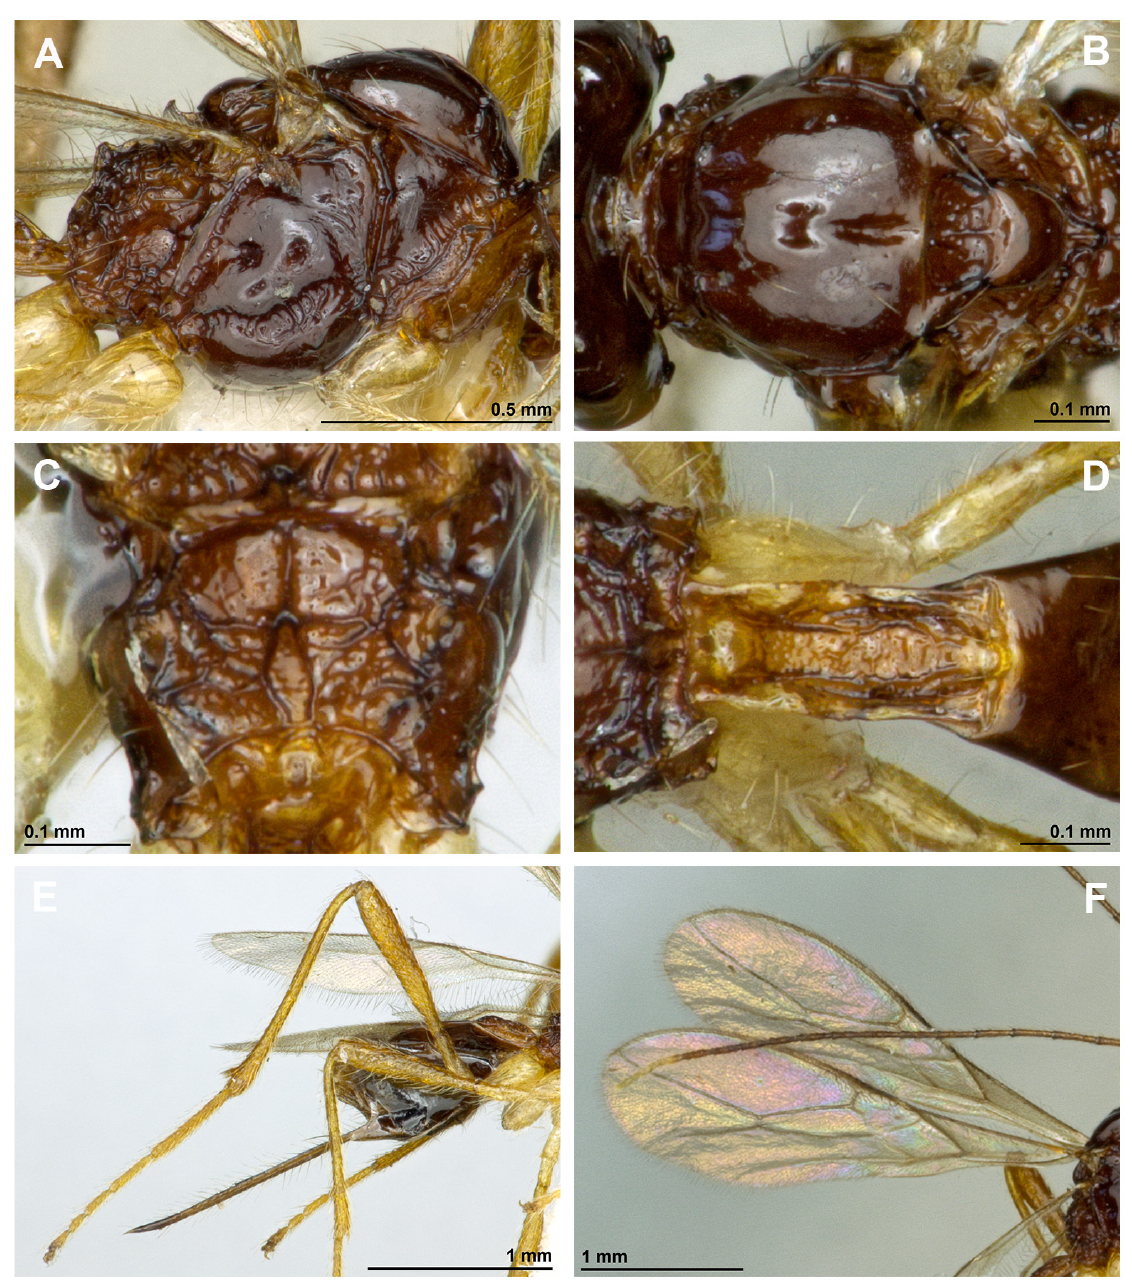
Fig. 59. Asobara stubbsi Peris-Felipo, sp. nov., ♀, holotype (BMNH 1972-211). A . Mesosoma, lateral view. B . Mesoscutum, dorsal view. C . Propodeum. D . First metasomal tergite, dorsal view. E . Hind leg, metasoma and ovipositor, lateral view. F . Fore